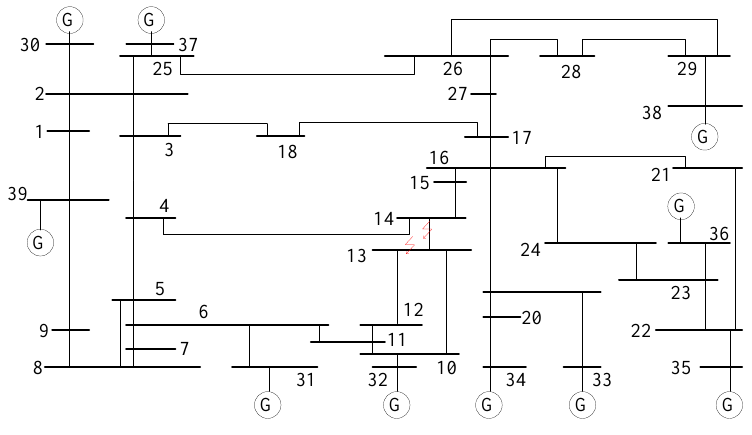
Figure 13. Double faults of the IEEE 39-bus system.